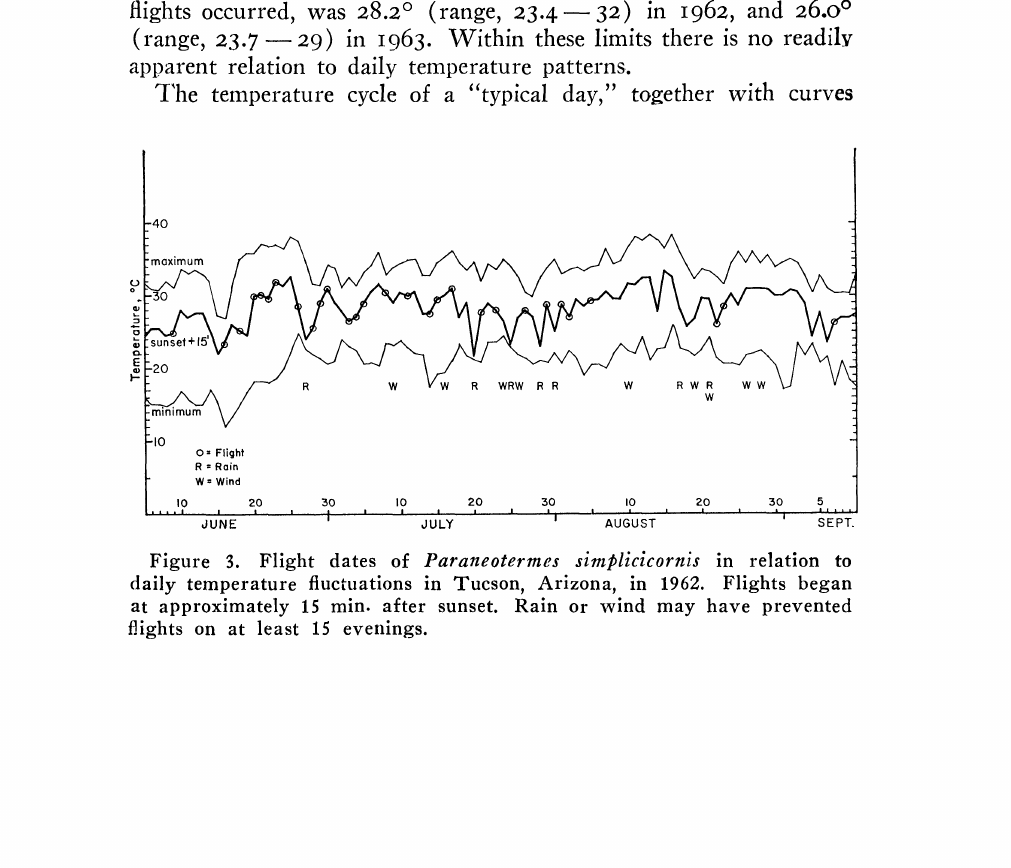
Figure 3. Flight dates of Paraneotermes simDlicicornis in relation to daily temperature fluctuations in Tucson, Arizona, in 1962. Flights began at approximately 15 min. after sunset. Rain or wind may have prevented flights on at least 15